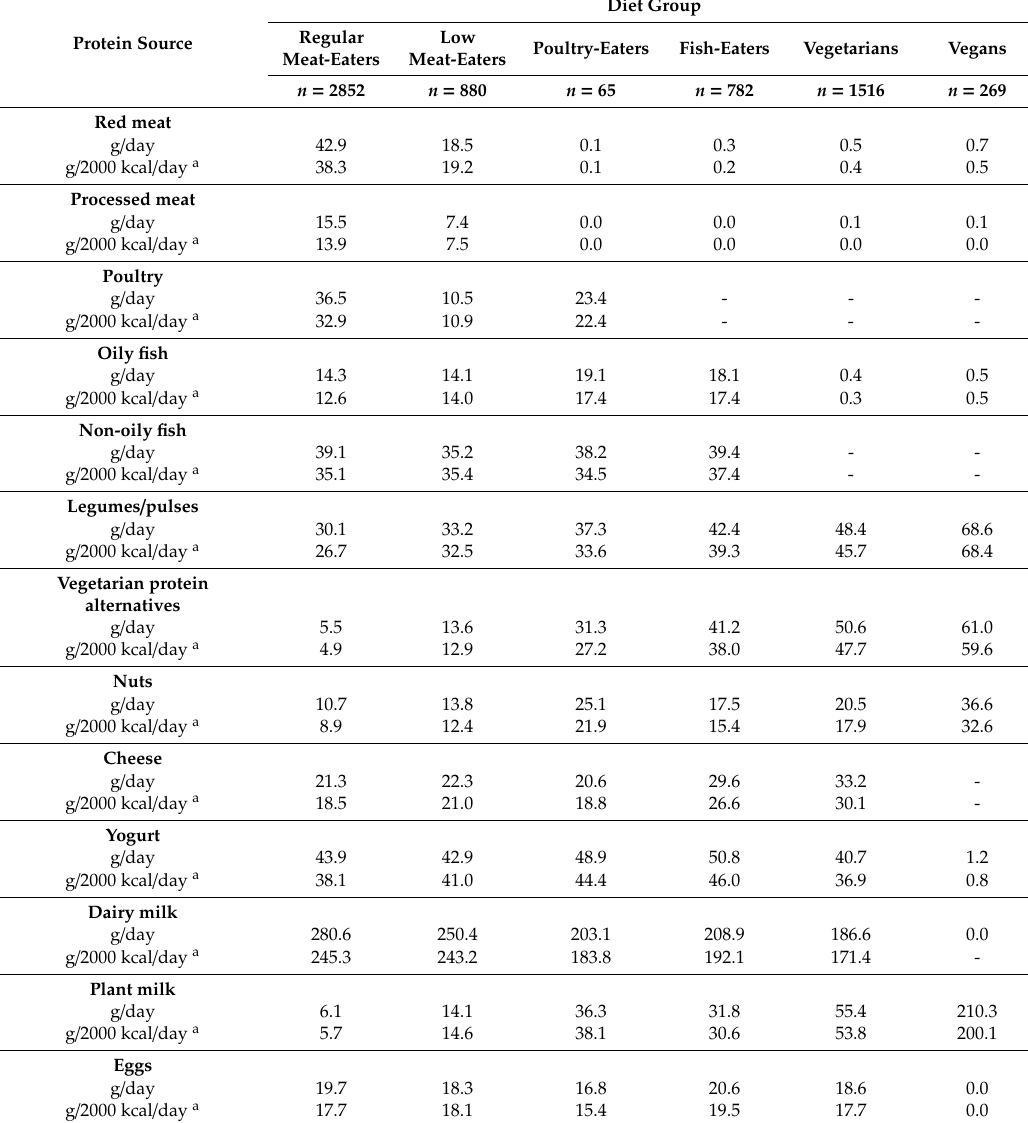
Table 2. Major protein-source food intakes in EPIC-Oxford